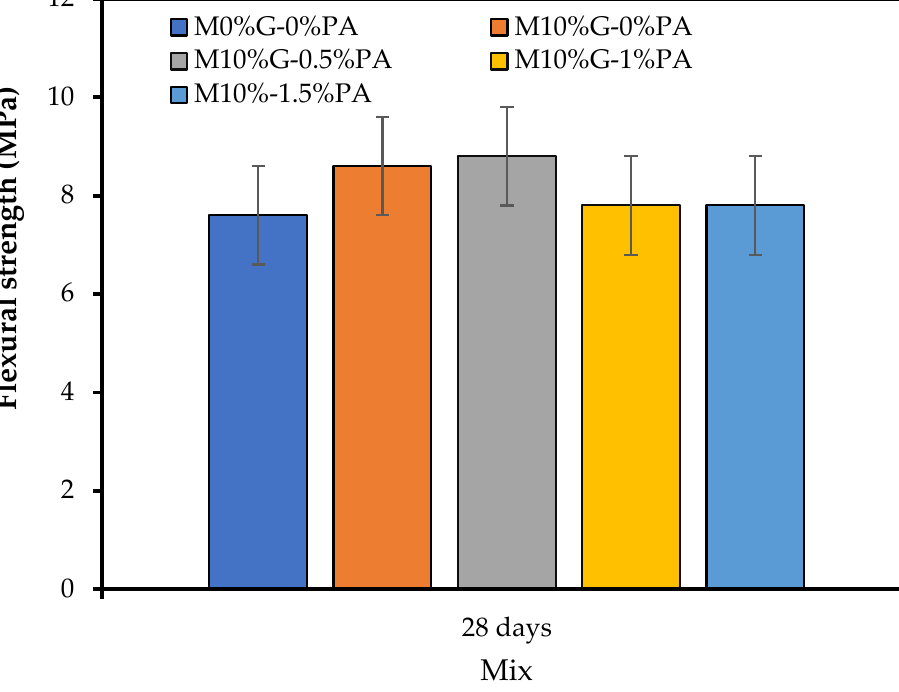
Figure 11. Flexural strength for prisms with powder glass and PA fi bers (3 prisms/mix).